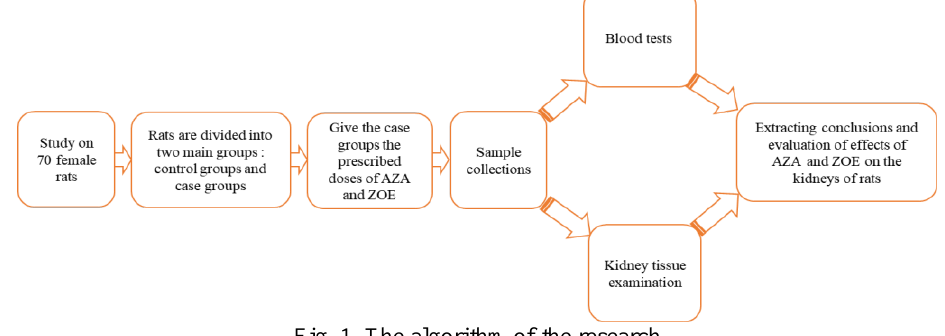
Fig. 1. The algorithm of the research